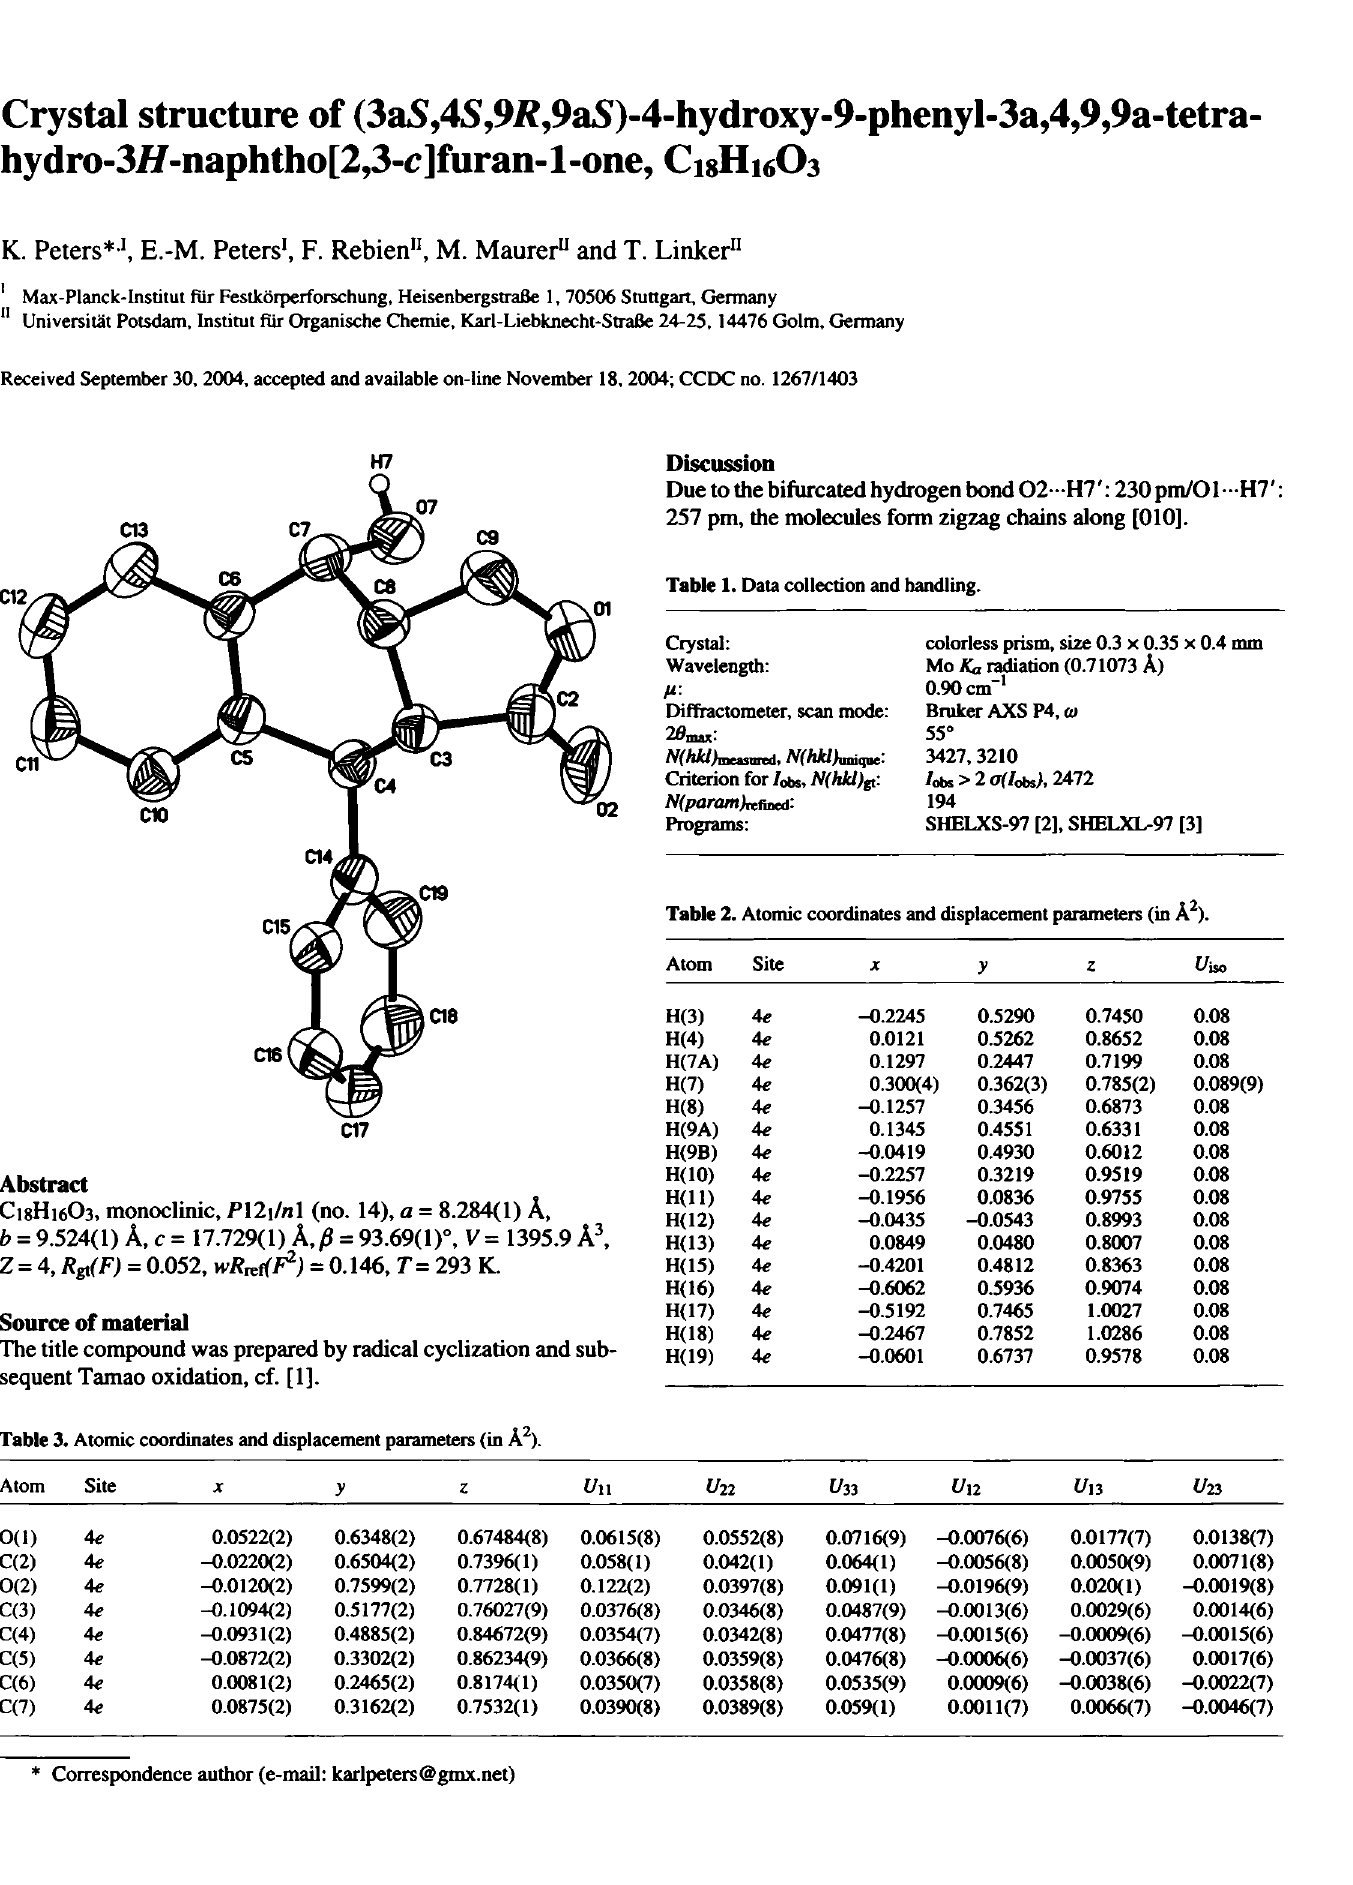
Table 1. Data collection and handling.